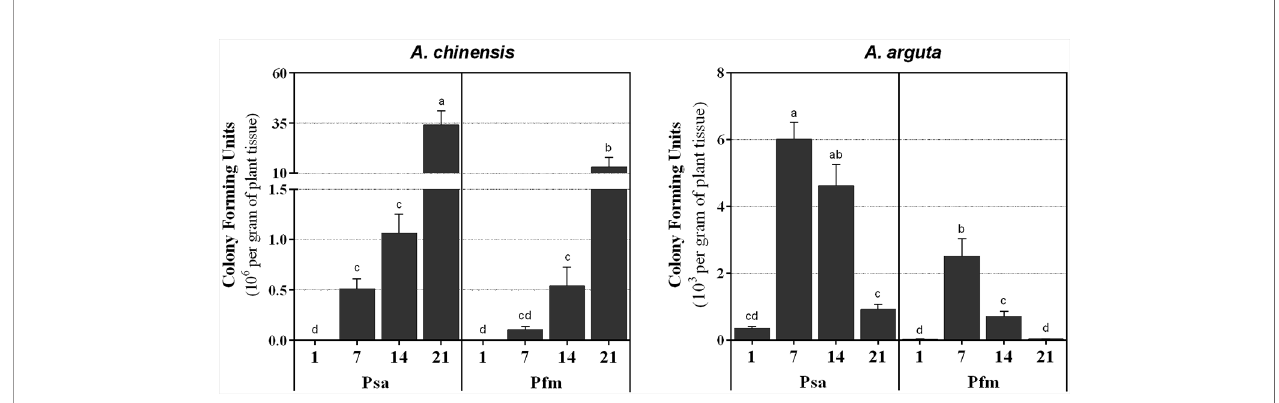
FIGURE 2 | Number of colony forming units (CFU per gram of plant tissue) in Actinidia chinensis var. deliciosa cv. ‘ Hayward ’ and A. arguta var. arguta cv. ‘ Weiki ’ plants inoculated with Pseudomonas syringae pv. actinidiae (Psa) or P. syringae pv. actinidifoliorum (Pfm) registered 1, 7, 14 and 21 days post inoculation (dpi). For each kiwifruit species, columns represent the mean of three independent replicates (consisting in the pool of three plants each) ± standard error. Columns with different letters are signi fi cantly different at p < 0.05. Note that the CFU scale (left x-axis) is different in the